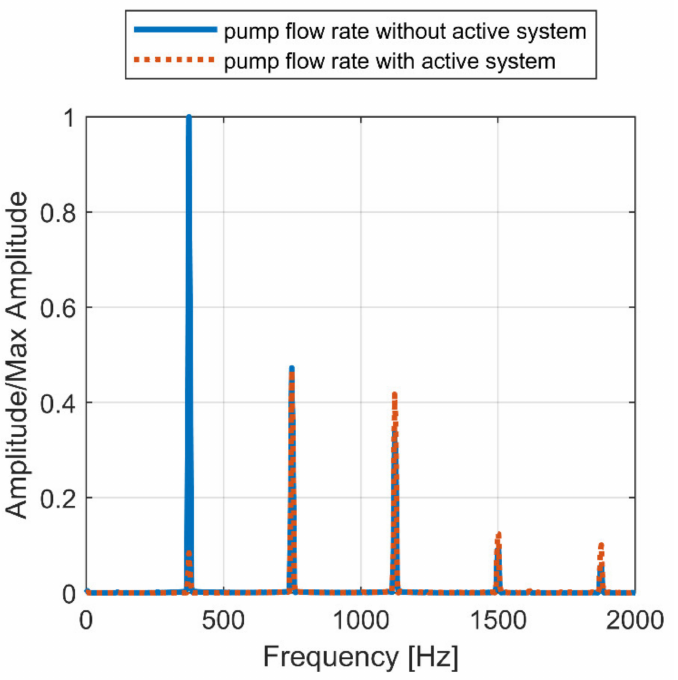
Figure 12. Simulation cycle 1, section 2: flow ripple FFT at 135 bar, 2500 rpm, 100% swash plate inclination.